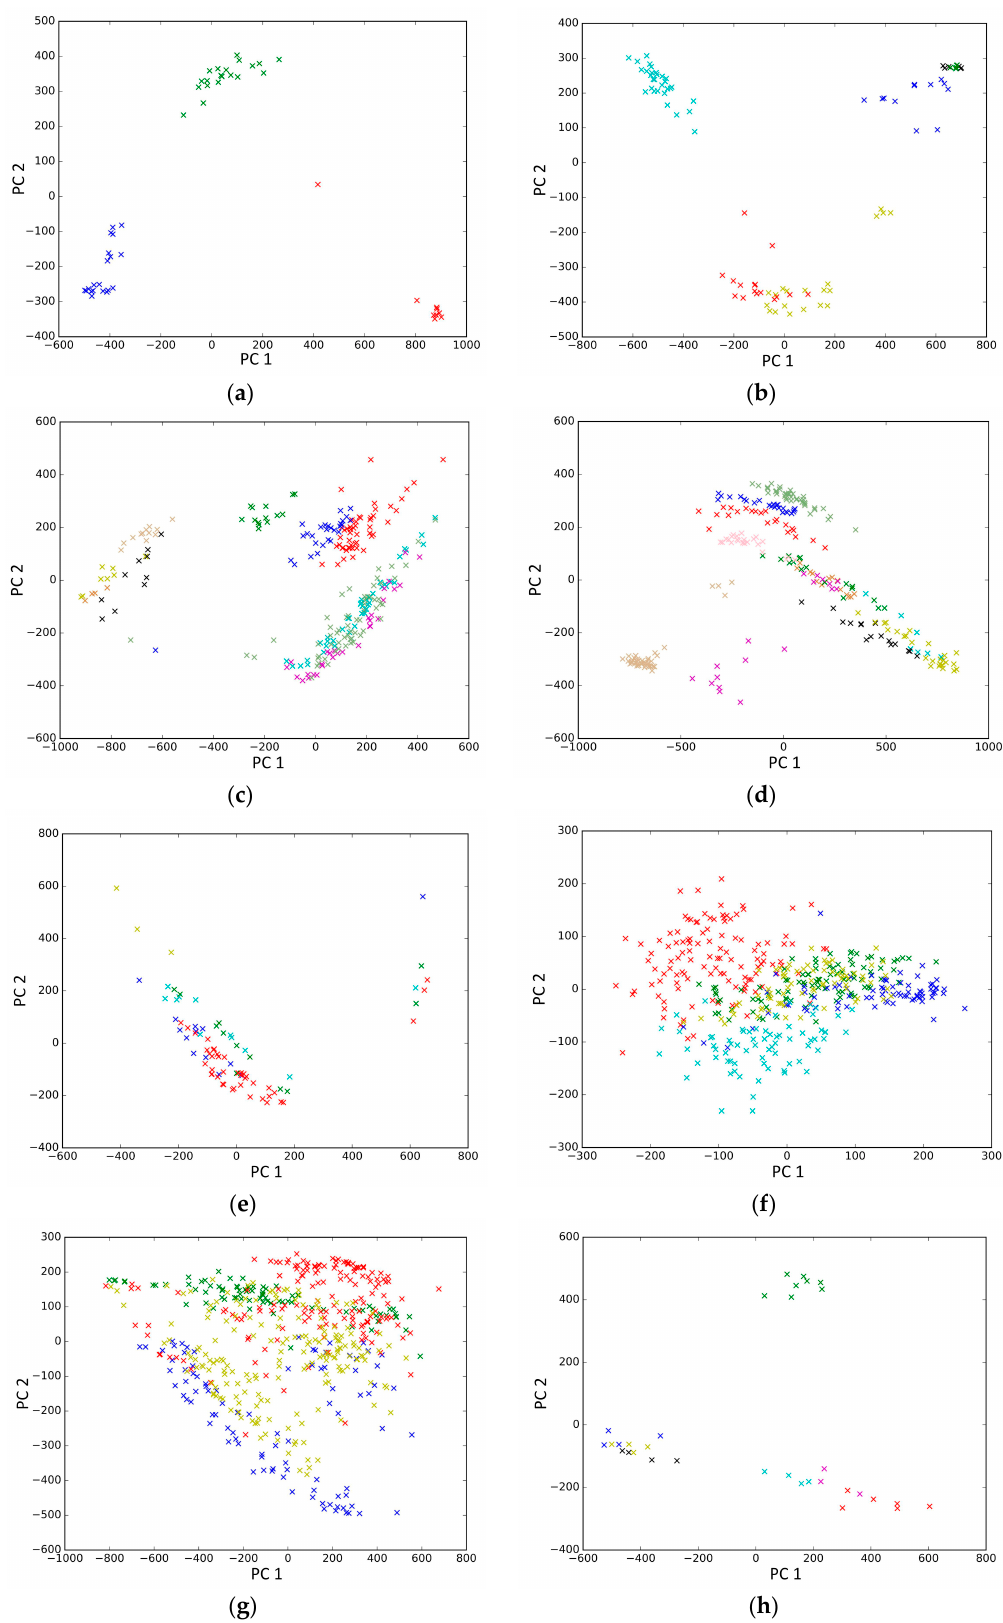
Figure 10. The scatter diagram of eight datasets by principal component analysis (PCA). ( a ) Biase; (b) Yan; ( c ) Deng; ( d ) Pollen; ( e ) Treutlein; ( f ) Patel; ( g ) Chung; ( h )